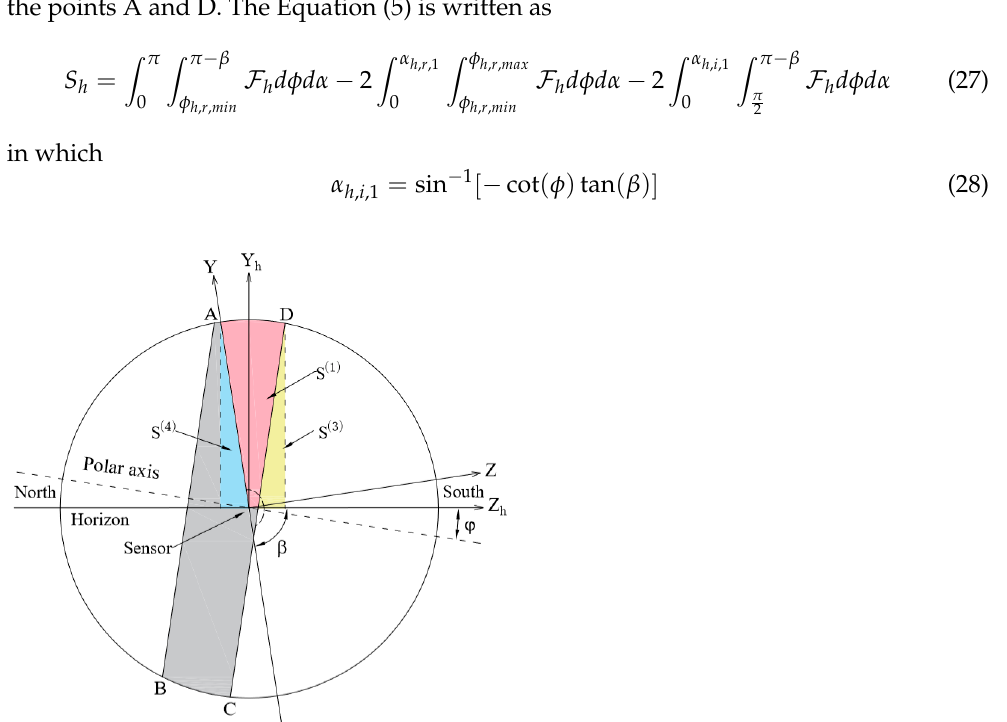
Figure 7. Schematic diagram for the calculation of S h while d l < 0 < d r and φ h , l , min > π − β . S ( 4 ) is the area, which is projected on the plane Y h OZ h by the spherical area below the slope surface, and will be used to represent the area in the following discussions. The spherical area is calculated by the third term on the right-hand side of Equation (27).